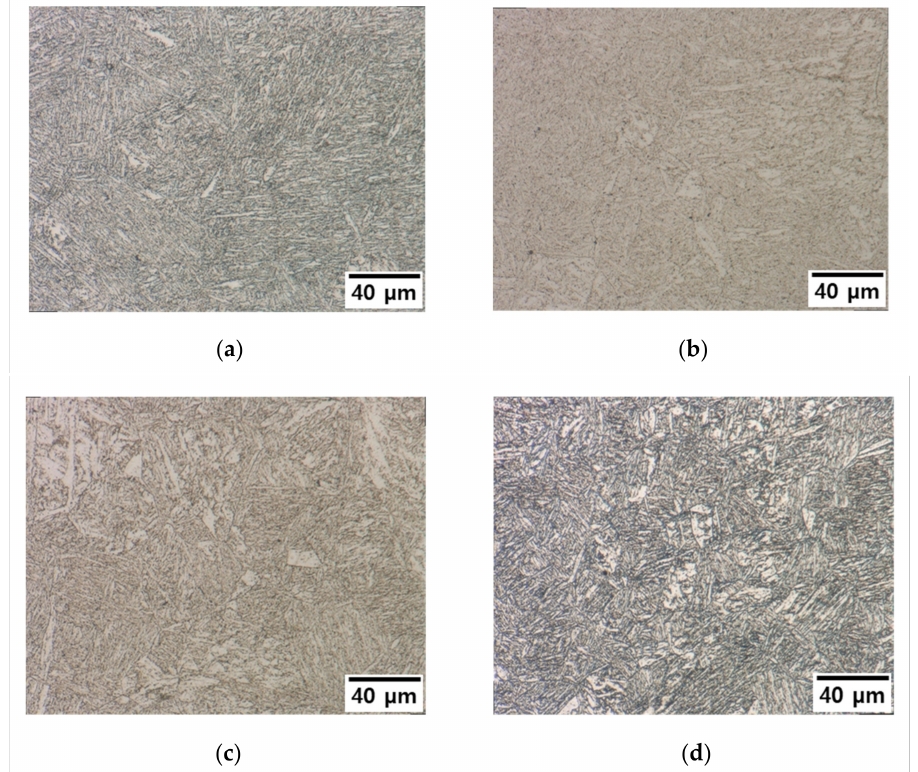
Figure 11. Microstructure according to tube type for specimens ( a ) No. 0, ( b ) No. 1, ( c ) No. 2, and ( d ) No.